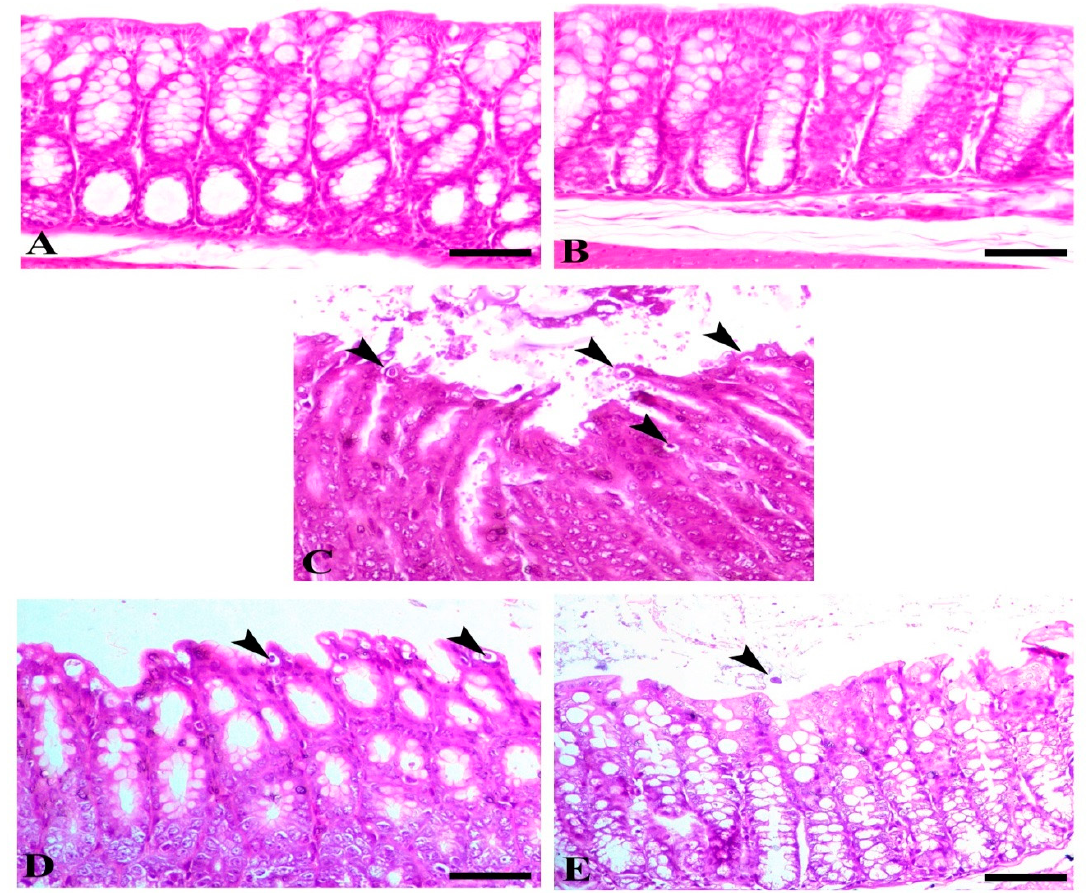
Figure 3. Intestine of different animal groups. ( A ) Control, ( B ) sham SMC50, ( C ) C + ve (arrowheads indicate numerous parasitic oocysts), ( D ) C + SMC25, and ( E ) C + SMC50 both intestinal sections showing a marked decrease of the intestinal oocyst (arrowheads). Hematoxylin and eosin (H&E) stain, bar = 50 μ m.